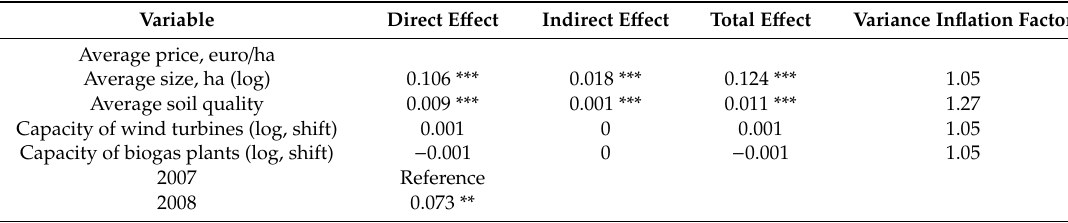
Table 2. Regression results from the community-based model ( N =